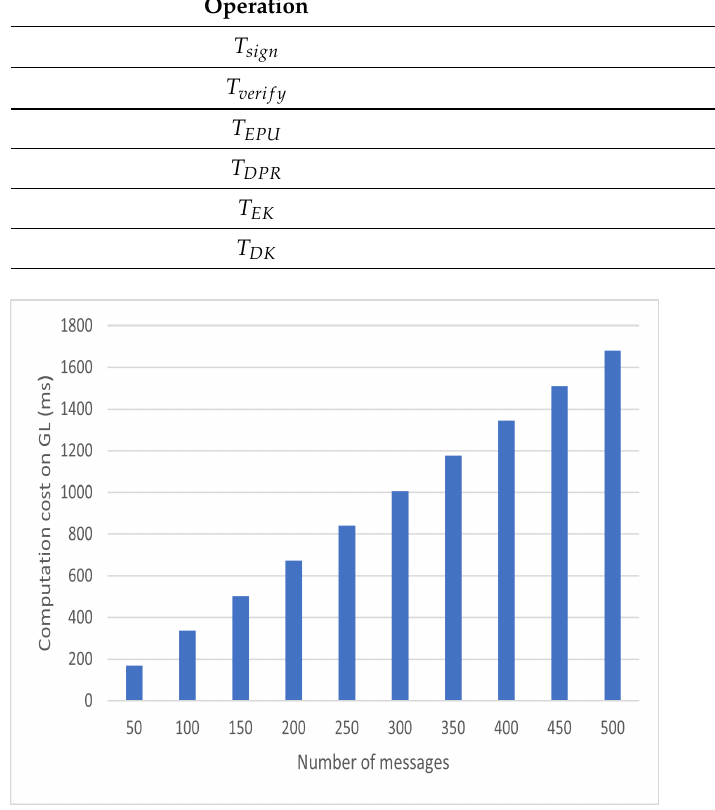
Figure 3. Total computation time at a GL for various numbers of messages.